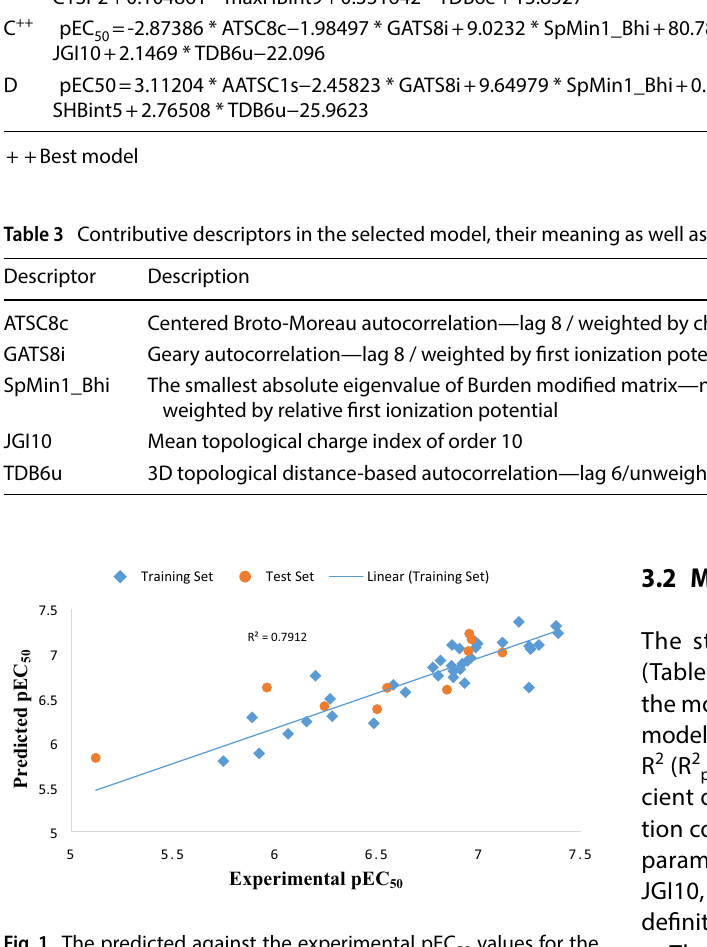
values for the 50